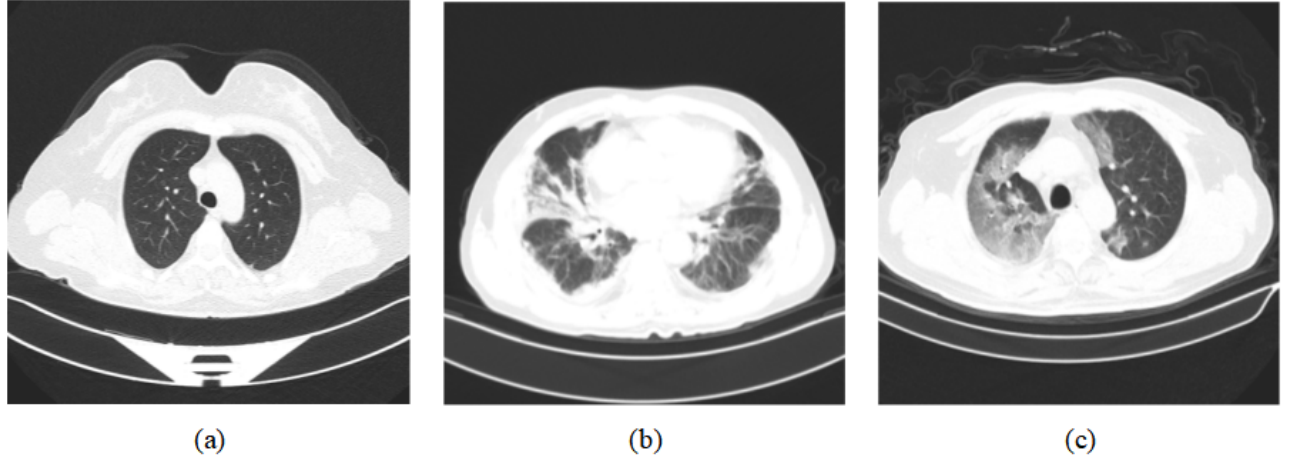
Figure 6. Dataset sample CT images [11,12]. ( a ) represents normal CT scan; ( b ) represents pneumonia CT scan; ( c ) represents COVID-19 CT